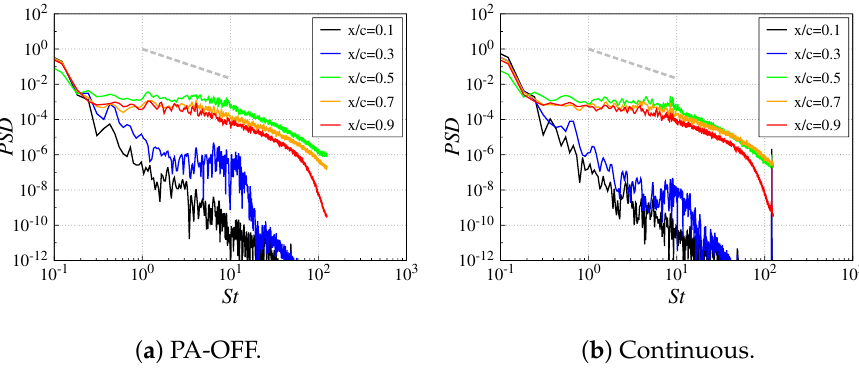
Figure 15. Power spectrum densities (PSDs) of the chordwise velocity fluctuations at the point of the maximum TKE directly above each code length at α = 6.